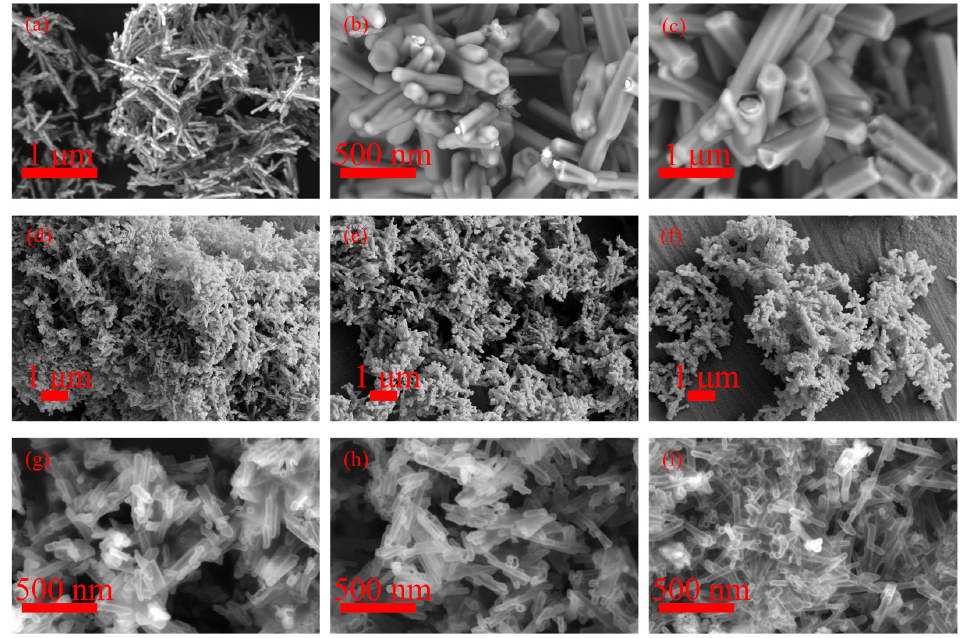
Figure 1. SEM images of ( a ) ZnO@SiO 2 − 1, ( b ) ZnO@ SiO 2 − 2, ( c ) ZnO@ SiO 2 − 3, ( d ) SiO 2 − 1, ( e ) SiO 2 − 2, ( f ) SiO 2 − 3, ( g ) SiO 2 @C − 1, ( h ) SiO 2 @C − 2, ( i ) SiO 2 @C − 3. ( f ) SiO 2 -3, ( g ) SiO 2 @C-1, ( h ) SiO 2 @C-2, ( i ) SiO 2